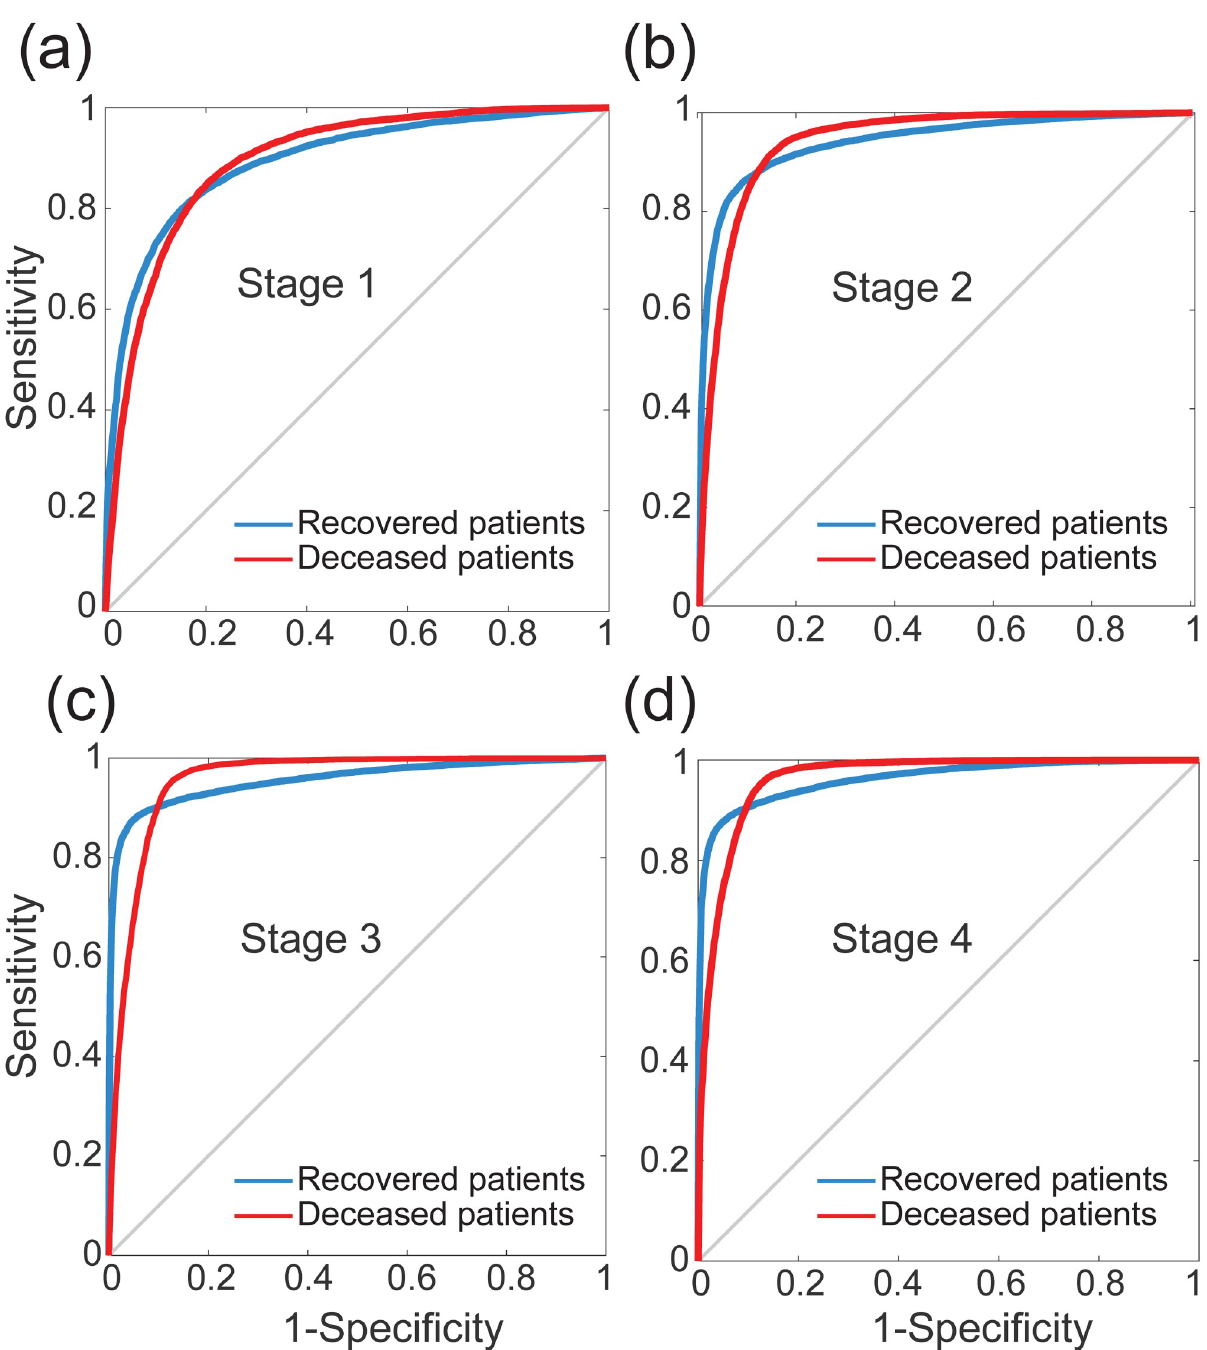
Fig 7. Receiver operating characteristic (ROC) curves that illustrate the diagnostic ability of the neural networks for rapid identification of high- risk patients in each stage: (a) Stage 1, (b) Stage 2, (c) Stage 3, and (d) Stage 4. The blue lines correspond to recovered patients, whereas the red lines depict the deceased